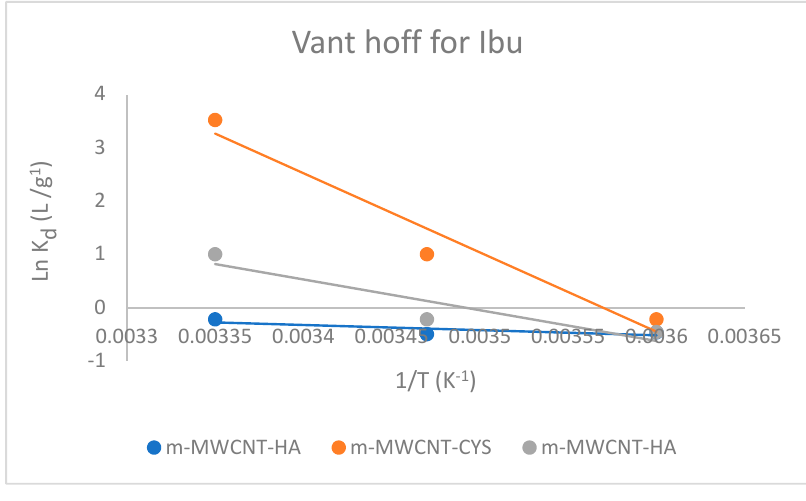
Figure 12. The Van’t Hoff plot for Ibu adsorption on m-MWCNT–HA, m-MWCNT–CYS, m-MWCNT–HYD. Table 4. Thermodynamic parameters for the adsorption of Ibu on m-MWCNT–HA, m-MWCNT–CYS, and m-MWCNT–HYD.